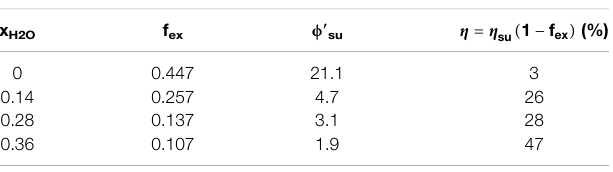
TABLE 4 | Mass transfer resistance data vs. %.mt H 2 O.